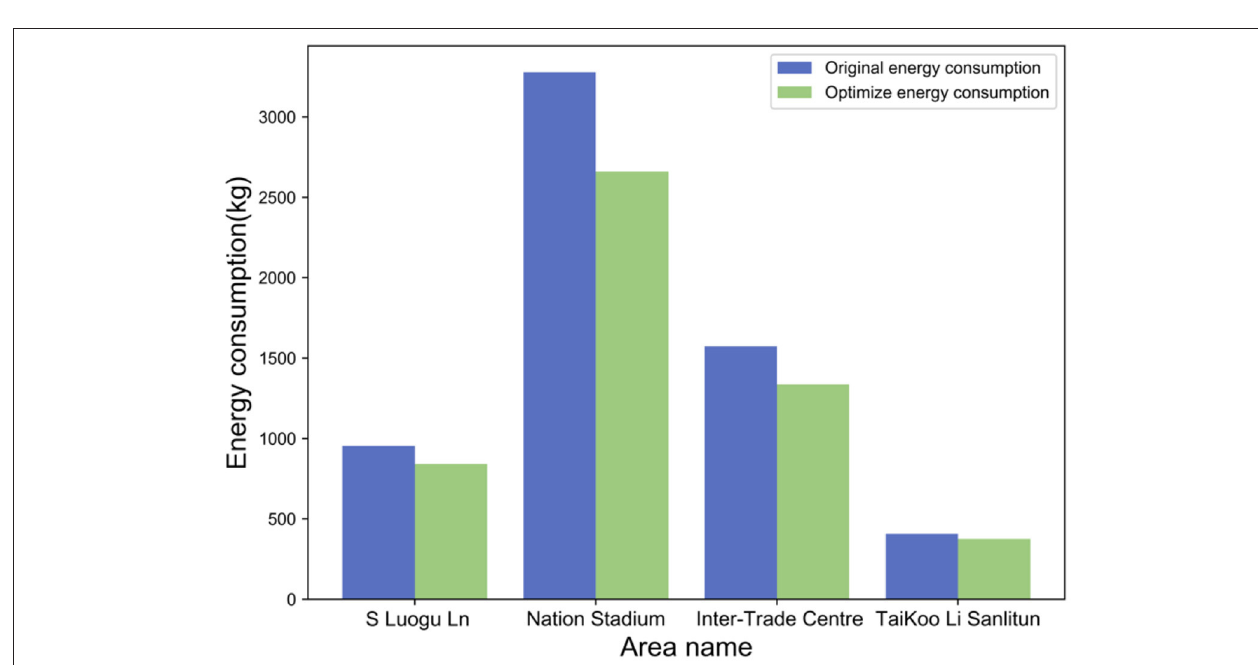
FIGURE 14 | Four types of regional energy consumption results before and after RSO strategy